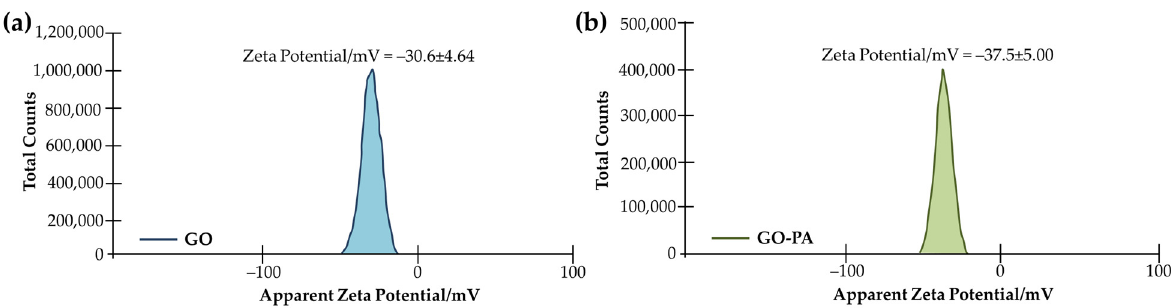
Figure 4. Average zeta potentials of GO ( a ) and GO-PA ( b ) in water dispersion.